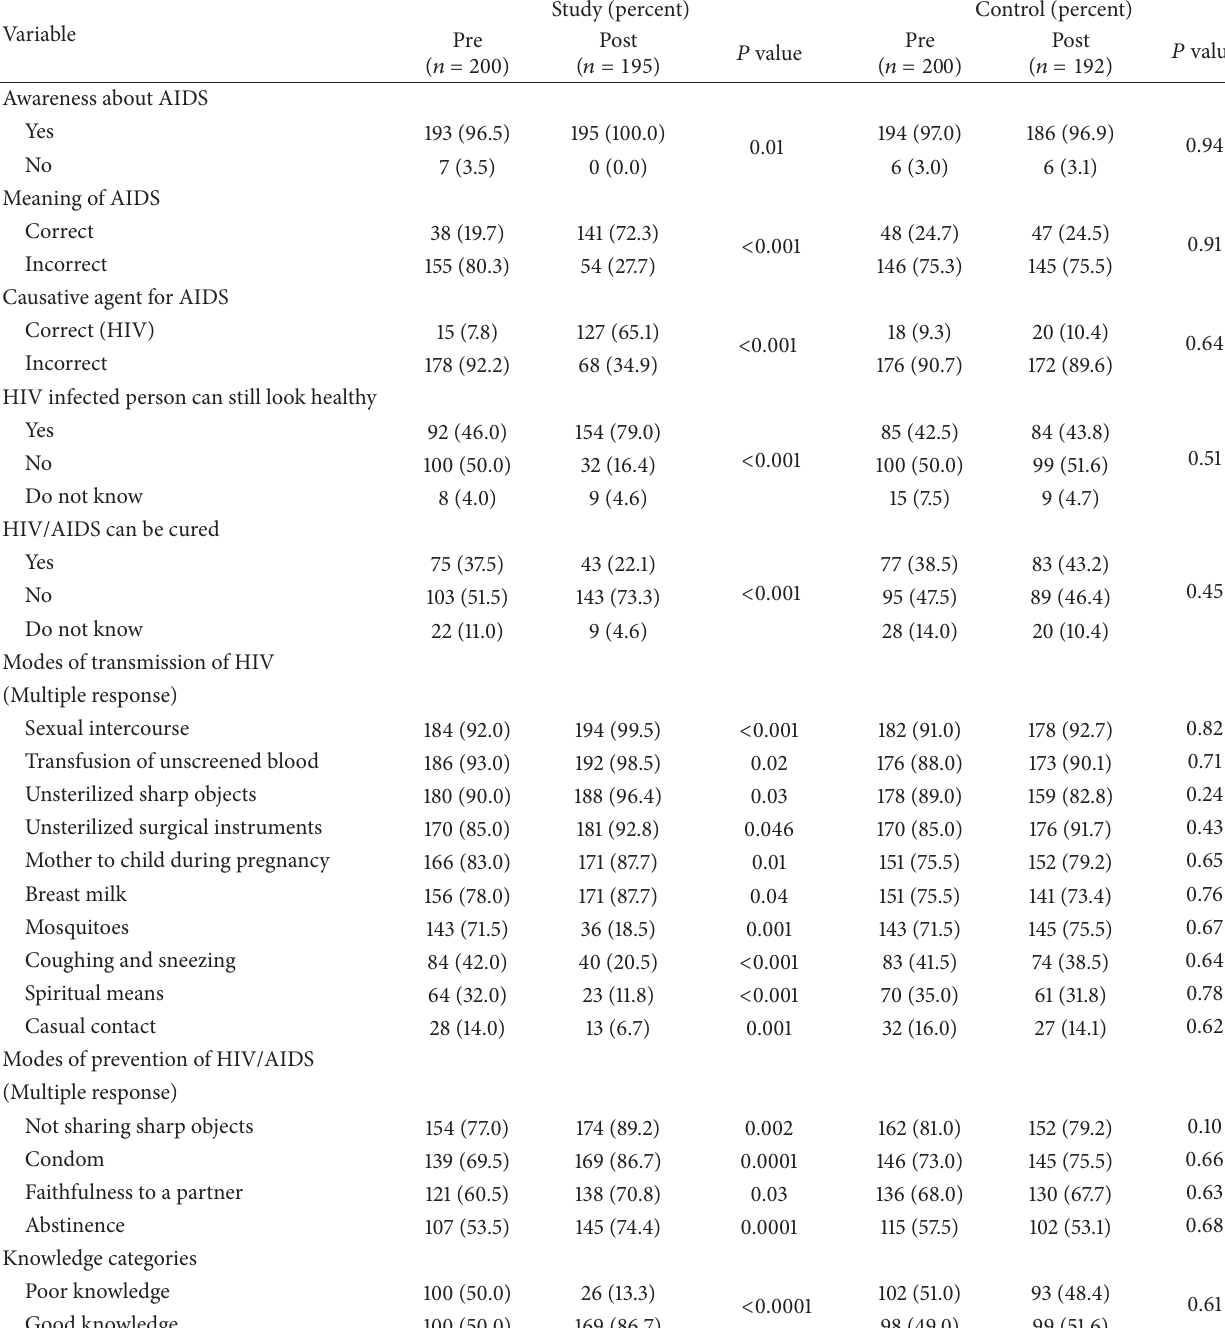
Table 5: Postinterventional knowledge of respondents about